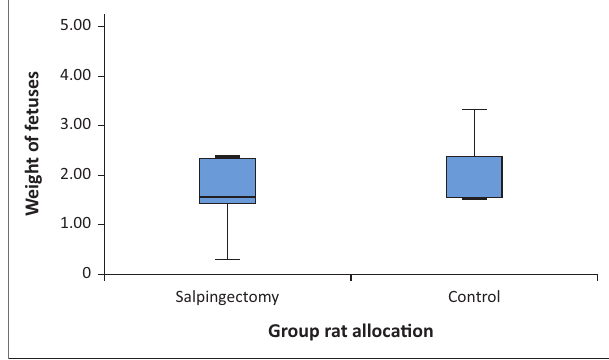
FIGURE 3: Box plot demonstrating the median individual weight (in grams) of foetuses at the time of termination in the salpingectomy and control groups. The median individual foetal weight in the salpingectomy group is 1.6 with upper and lower quartile values of 1.4 and 2.3, respectively. The median individual foetal weight in the control group is 1.6 with upper and lower quartile values of 1.5 and 2.6, respectively. The whiskers show the 5th and 95th percentiles of the values,